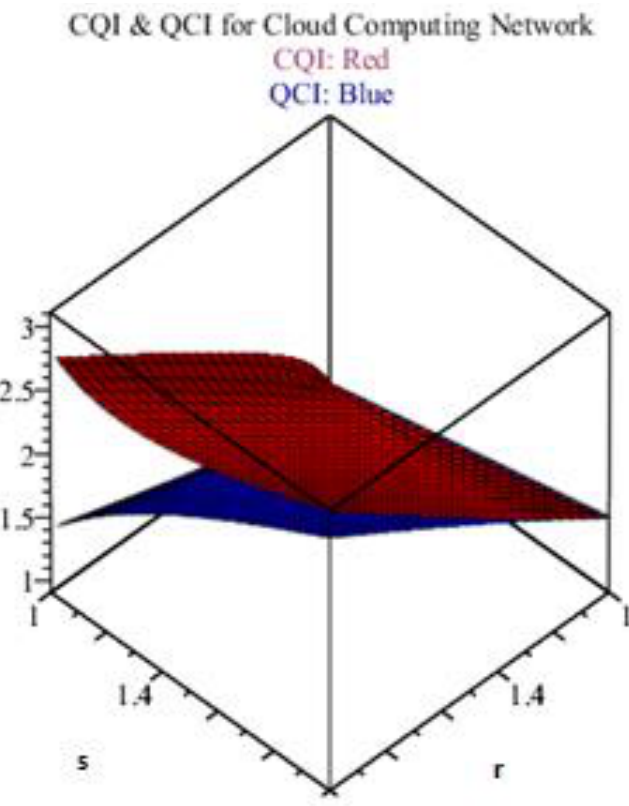
Figure 5. CQI and QCI for cloud network.